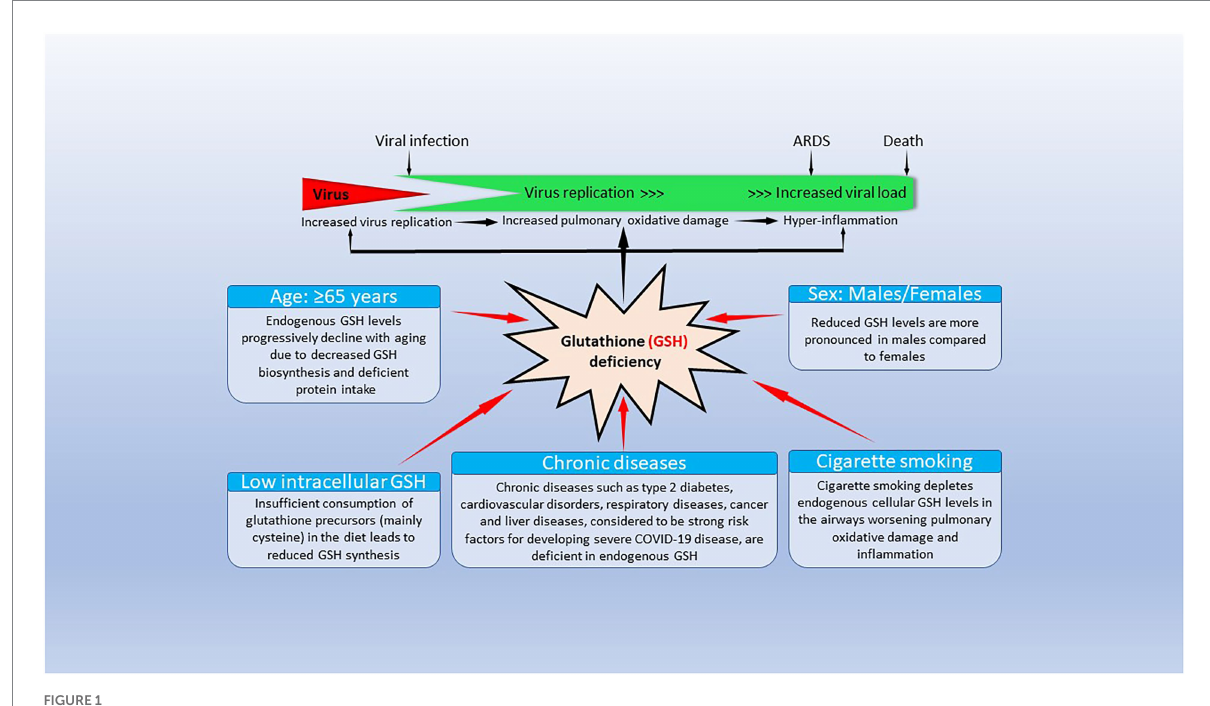
FIGURE 1 Factors causing endogenous glutathione (GSH) deficiency and GSH deficiency-mediated mechanisms contributing to coronavirus disease 19 (COVID-19) pathogenesis and outcomes. The bottom part of the figure shows that risk factors for severe COVID-19 infection lead to decrease/ depletion of intracellular GSH. The top part of the figure shows potential GSH deficiency-mediated mechanisms that could influence clinical manifestations and outcomes in COVID-19 disease. Modified from Polonikov